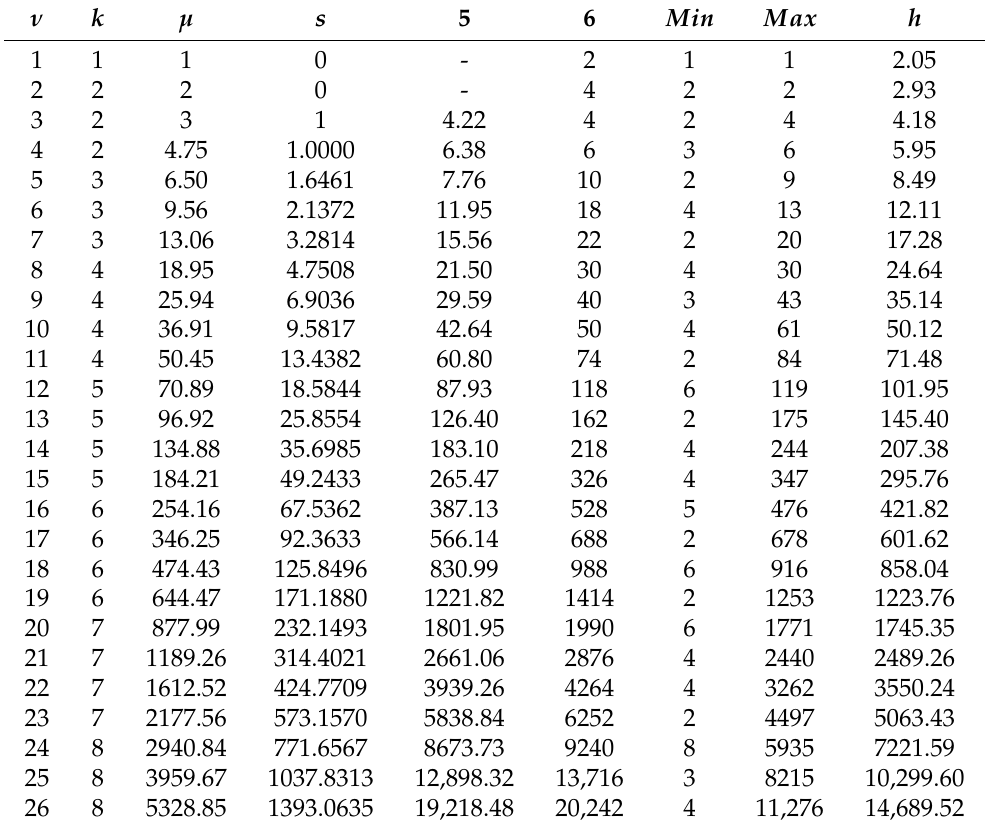
Table 2. Results of our exhaustive search ν = 1,2, . . . ,26. (see the description of columns